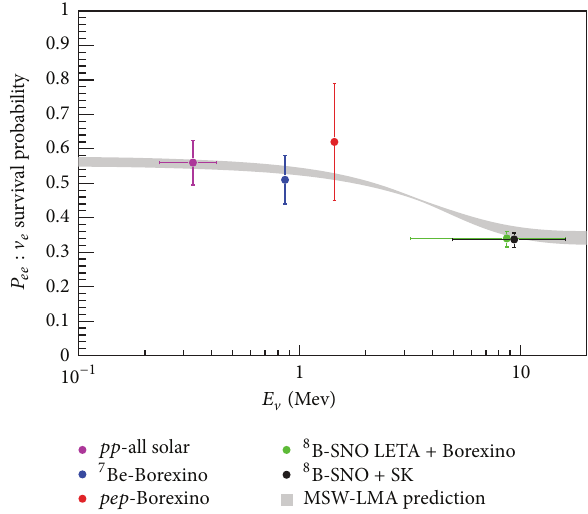
Figure 11: Solar ] 𝑒 survival probability [22] as a function of neutrino energy including all solar (with Borexino) experimental results. The grey band is the prevision of the LMA solution in the frame of MSW